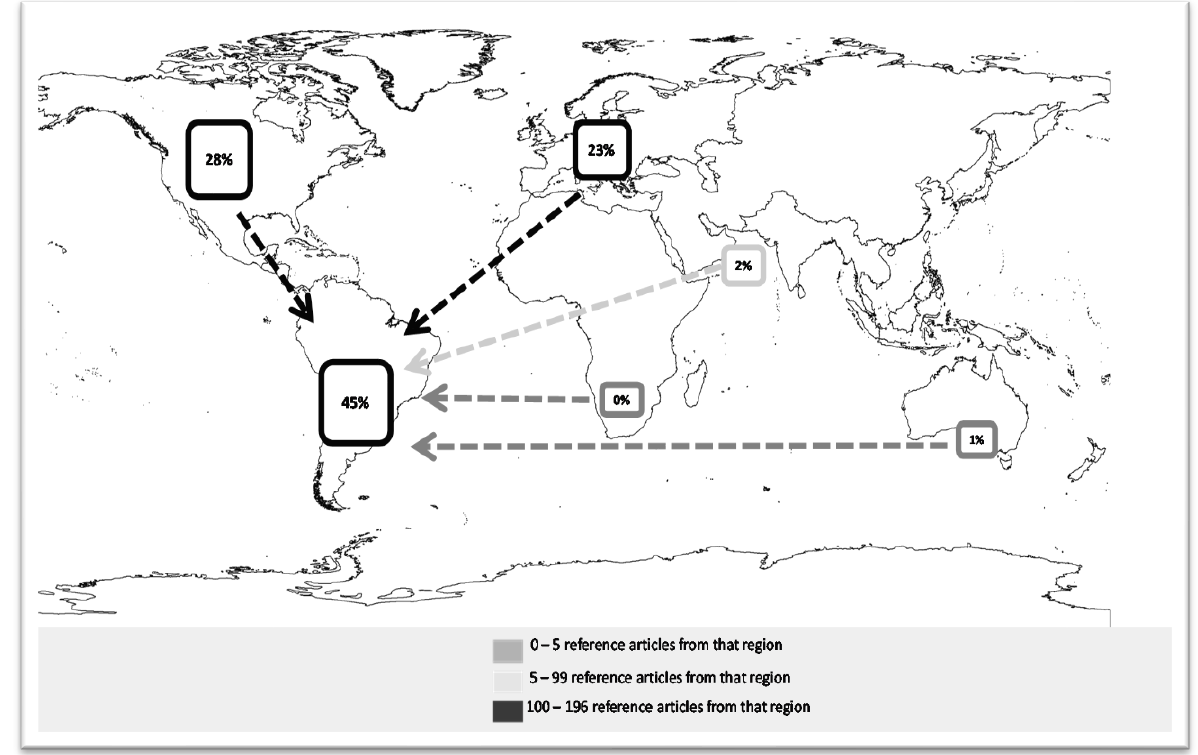
Figure 3: Knowledge-production influence in LAC research articles related to Crimes of the powerful (SciELO search) according to reference authors’ affiliation regions